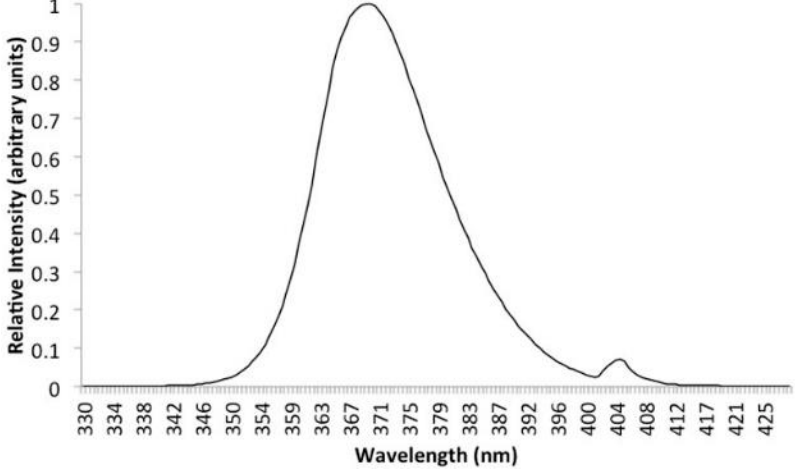
Figure 5. Intensity vs. wavelength.